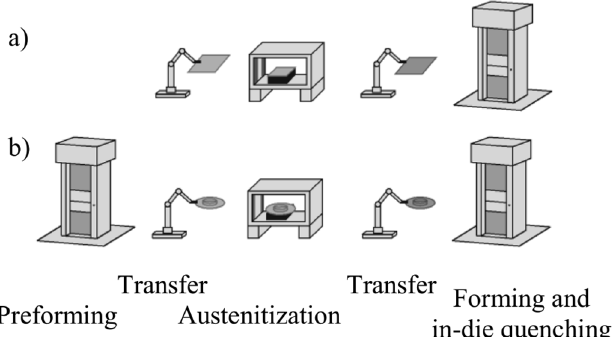
Fig. 1. Overview of the process steps in direct (a) and indirect (b) hot stamping according to [6].